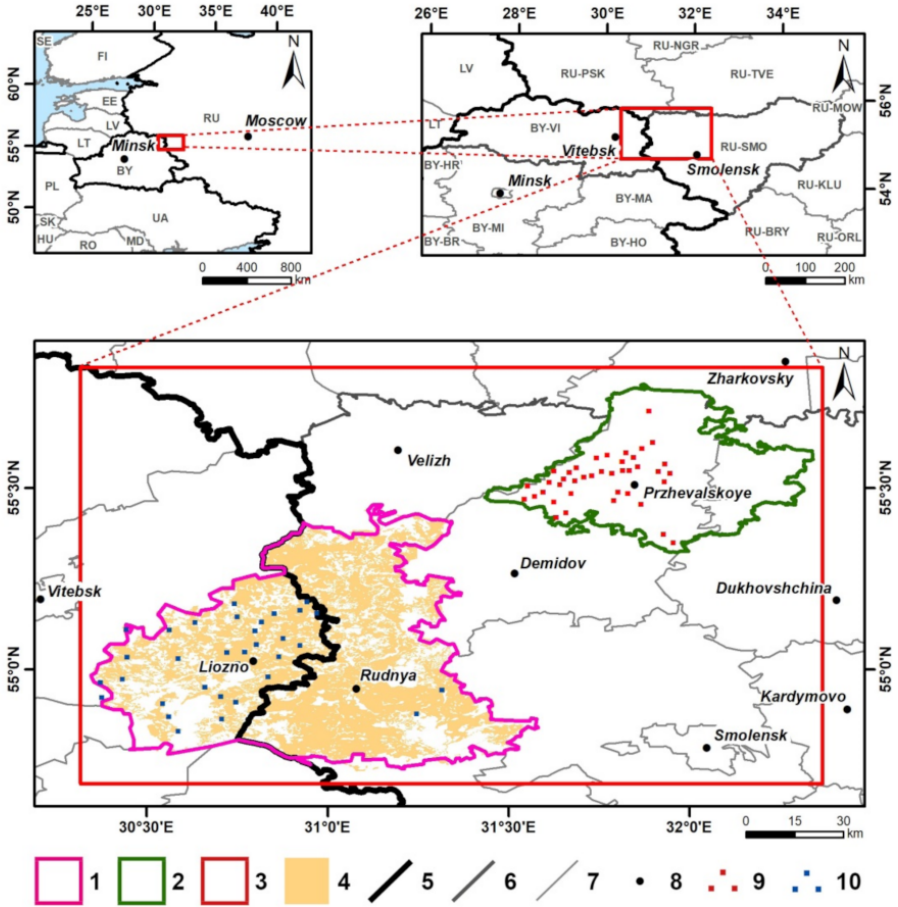
Figure 1. Study area. Legend: 1—Rudnya and Liozno districts borders; 2—Smolenskoe Poozerie National Park border; 3—Extended study area for Landsat mosaics generation; 4—Initial Agricultural Lands (IAL); 5—Russia and Belarus state border; 6–Smolensk and Vitebsk regions borders; 7—Other state and administrative borders; 8—Populated places; 9—Field plots; 10—Visually identified bare soil plots. Nearby located plots are depicted by single marker. Countries and regions are marked with ISO 3166